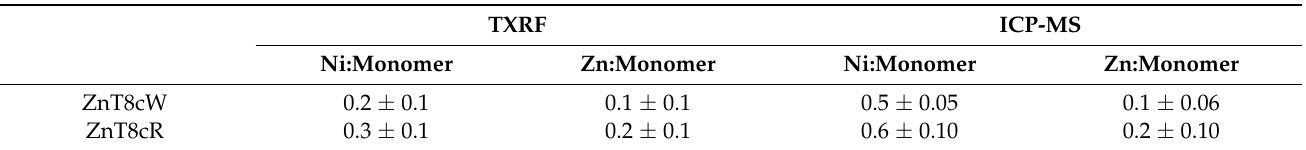
Table 3. Metal stoichiometries of ZnT8 variants from total reflection X-ray fluorescence (TXRF and ICP-MS metal analyses following new buffer preparation